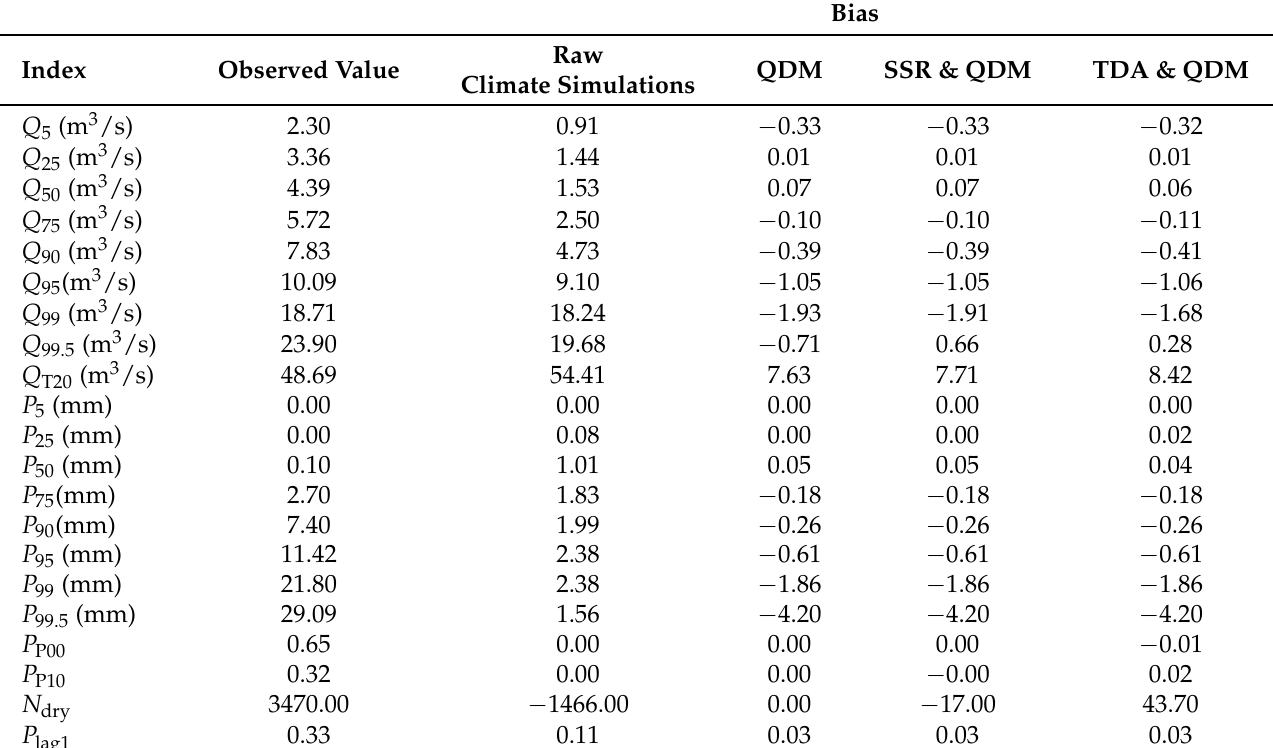
Table A1. Observed values, and biases for the raw climate simulations, and the combinations of QDM and occurrence-bias- adjusting